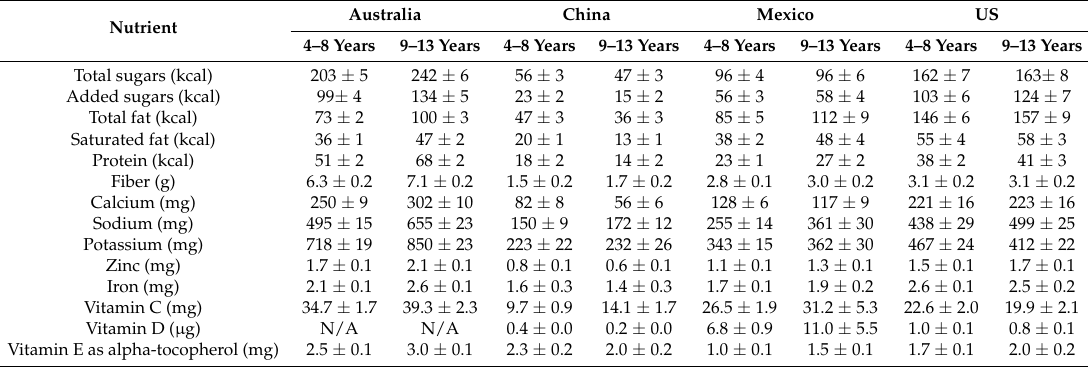
Table 2. Nutrient intakes from snacking occasions among children (per capita) in Australia, China, Mexico, and the US.